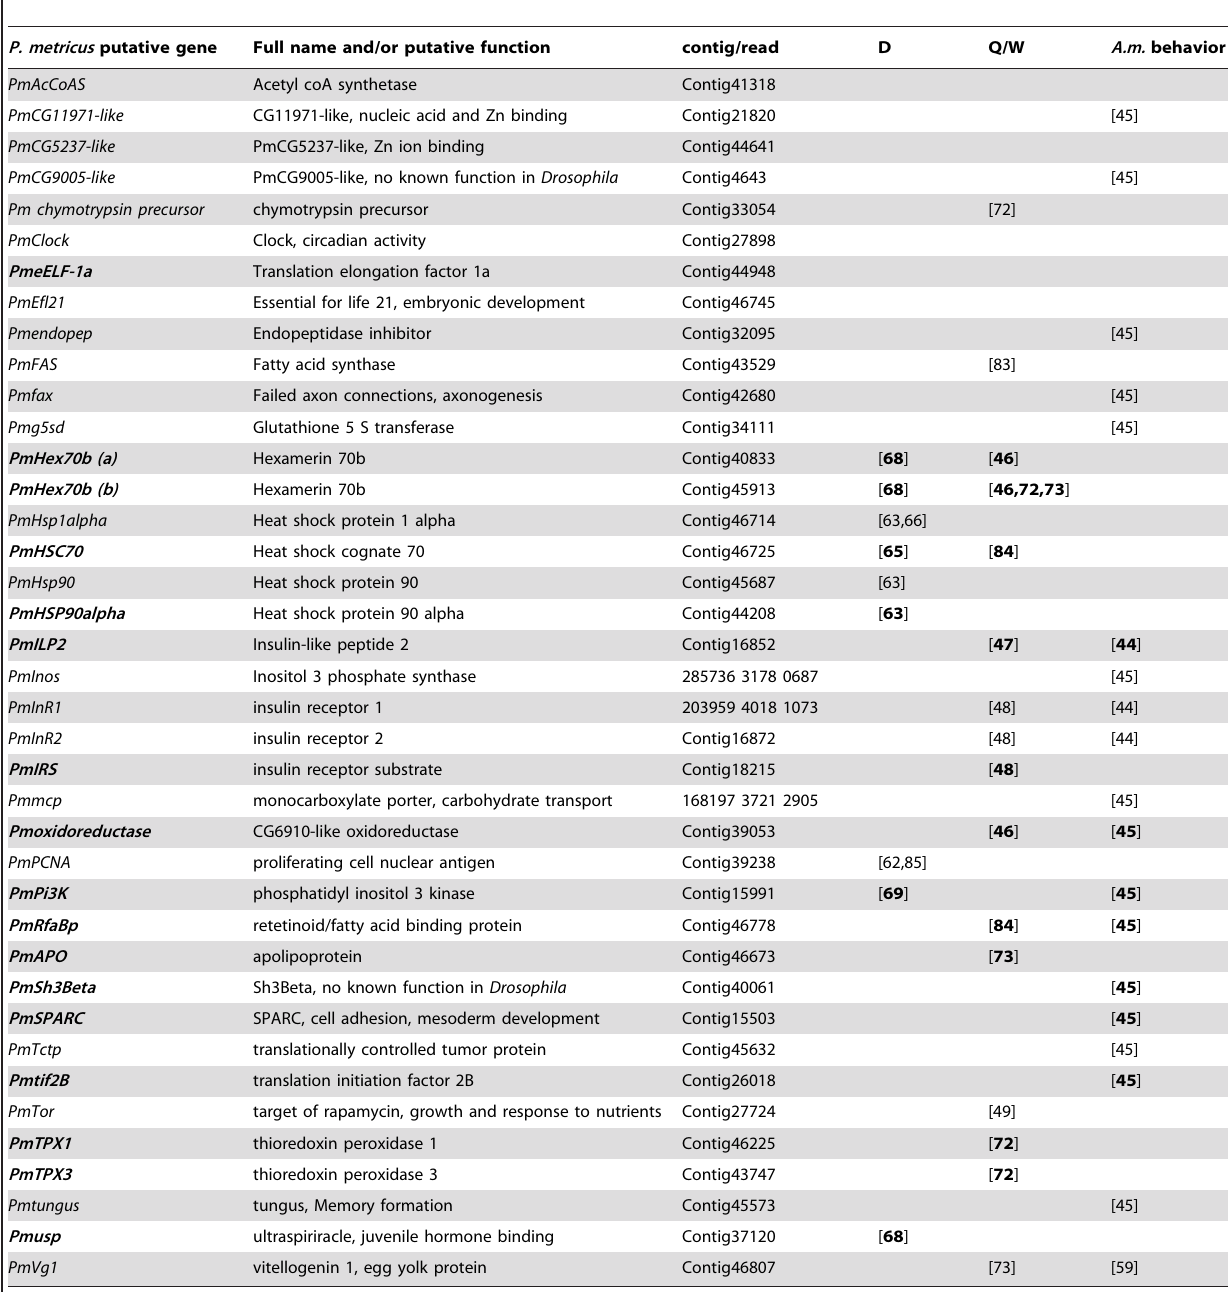
Table 1. Polistes metricus putative genes quantified in this study, their full name and/or putative function, and the contig/read